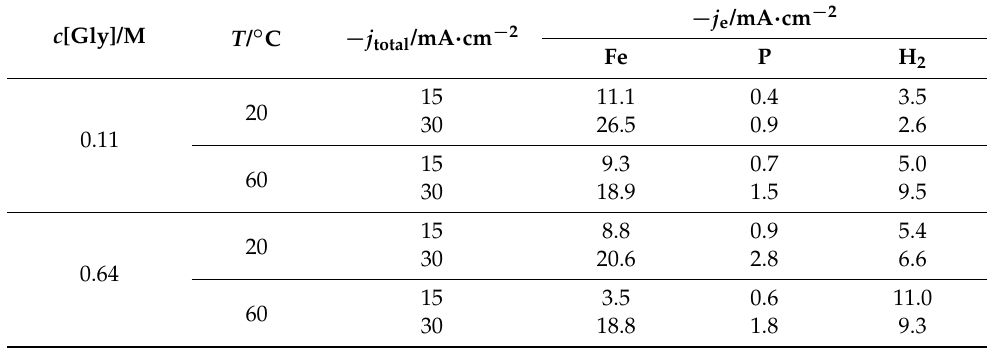
Table 2. Influence of temperature and Gly concentration on the partial cathodic current densities, j e , of the electrodeposition of Fe and P, and the hydrogen evolution (side reaction).